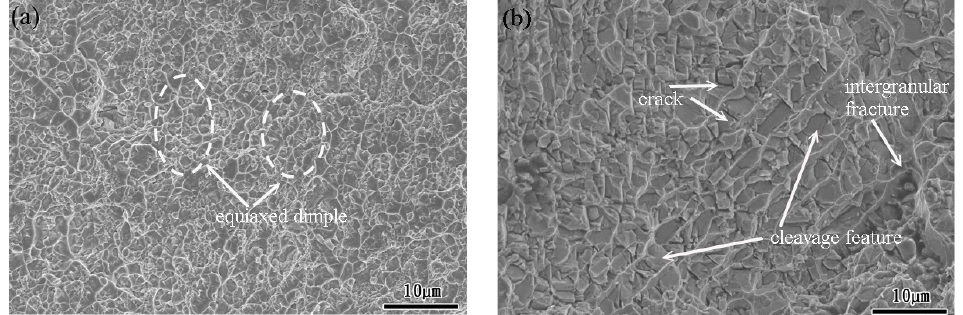
Figure 10. Fracture surface morphology of TiNi 44 Nb 2 alloy under ( a ) static deformation conditions, and ( b ) dynamic deformation conditions (2000× magnification).